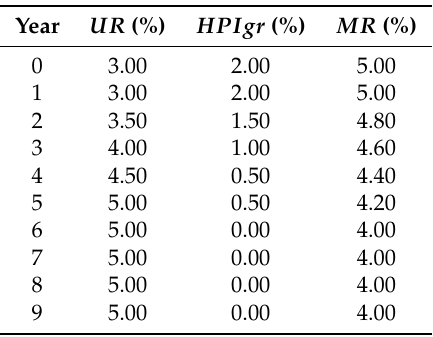
Table 3. Scenario for the macroeconomic factors UR , HPIgr , and MR